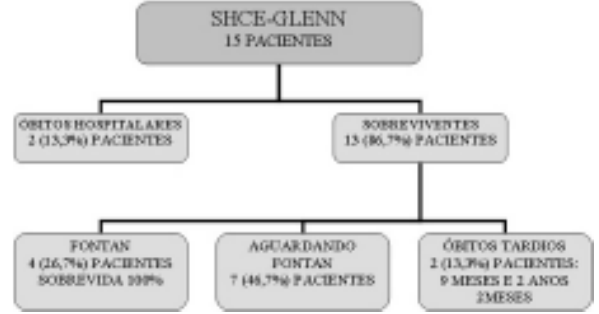
Fig. 3 - Diagrama da evolução após o segundo